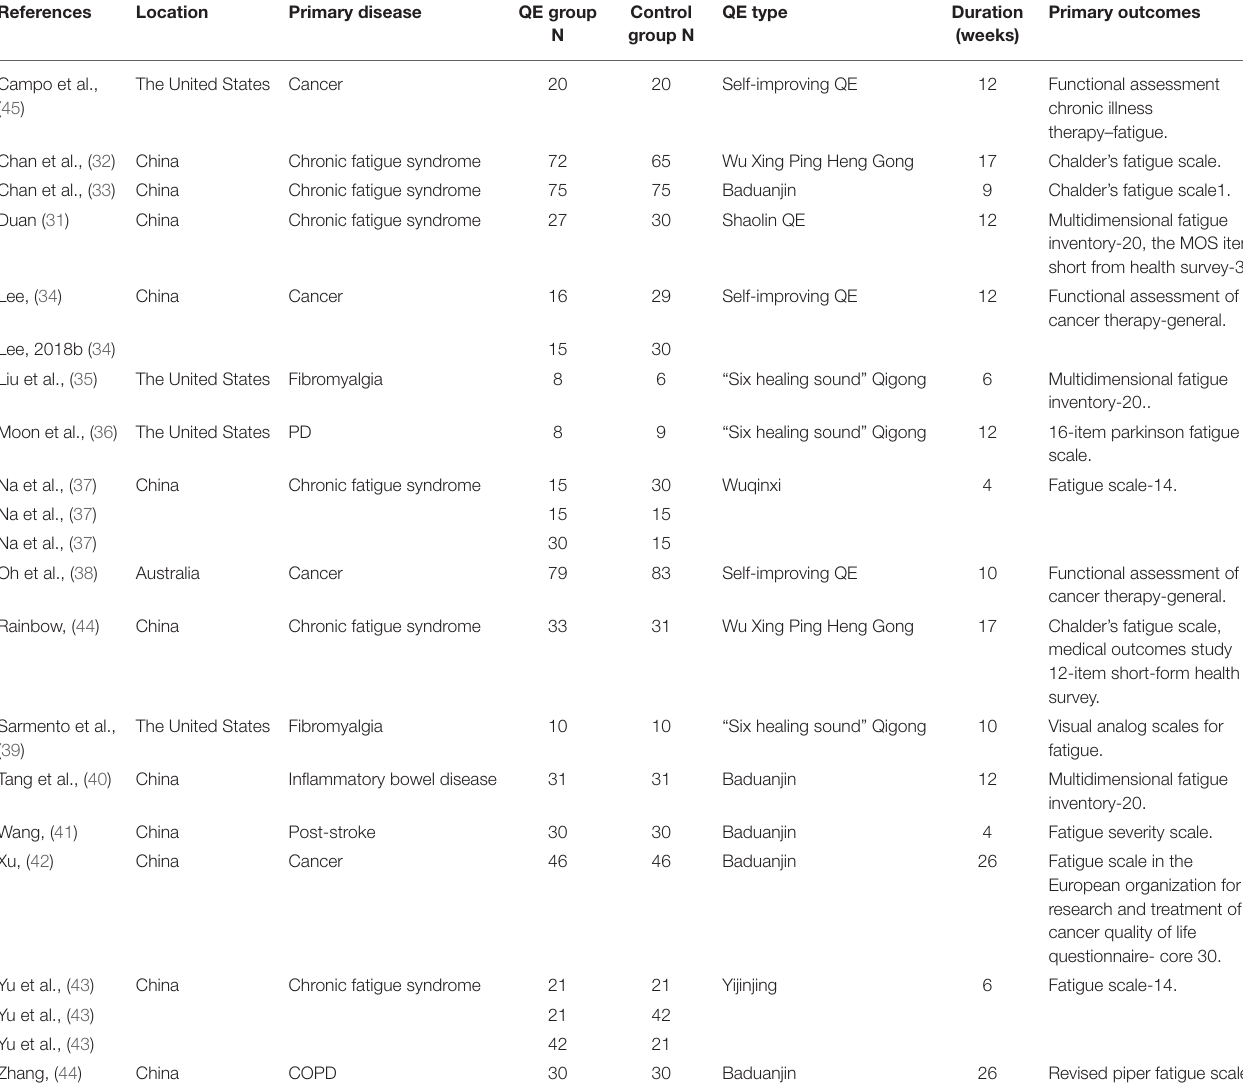
TABLE 1 | Characteristics of the included